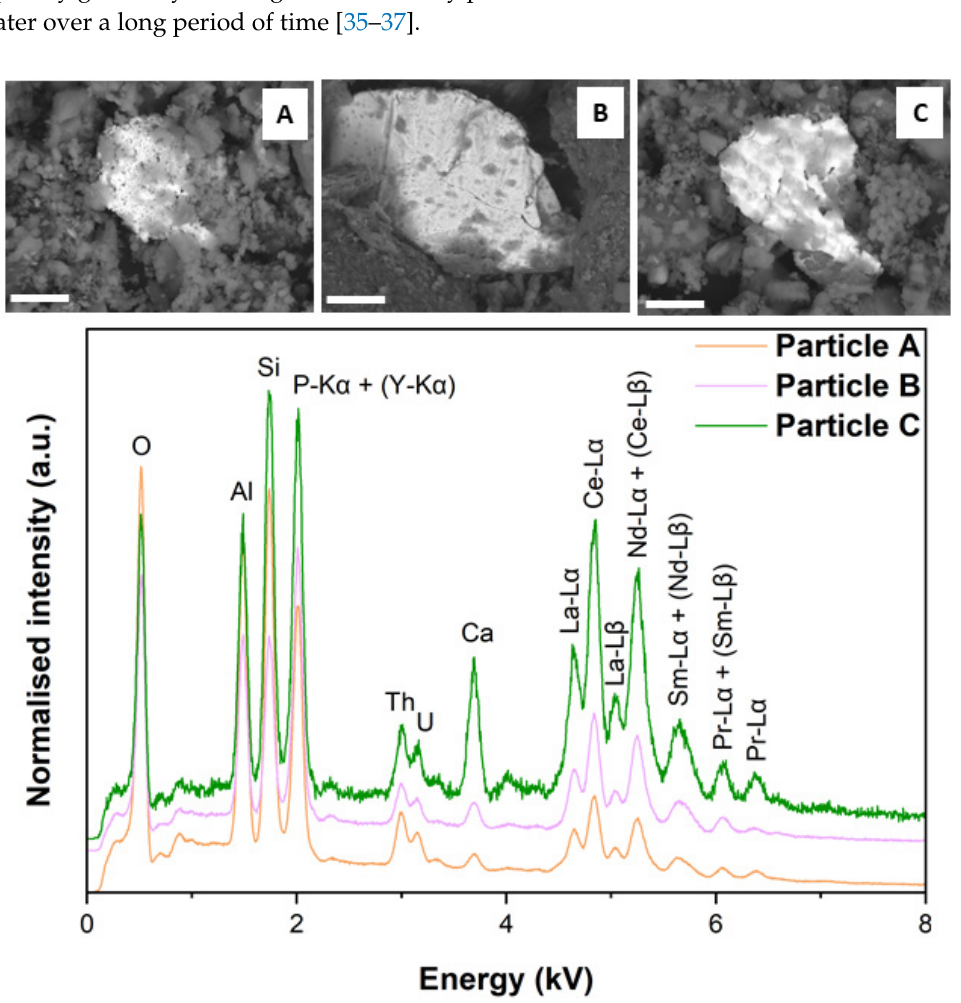
Figure 3. (Top) backscattered electron images of two uraninite particles ( D in Okaba coal ash and E in Omelewu coal ash). (Bottom) associated EDS spectra with emission peaks identified (scale bars = 5 μ m).